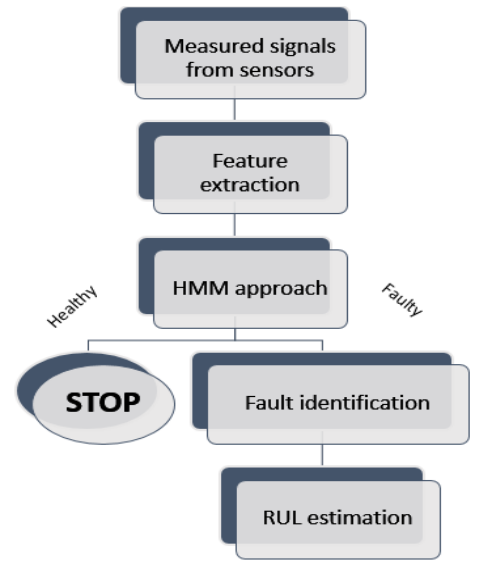
Figure 18. The prognostic strategy.